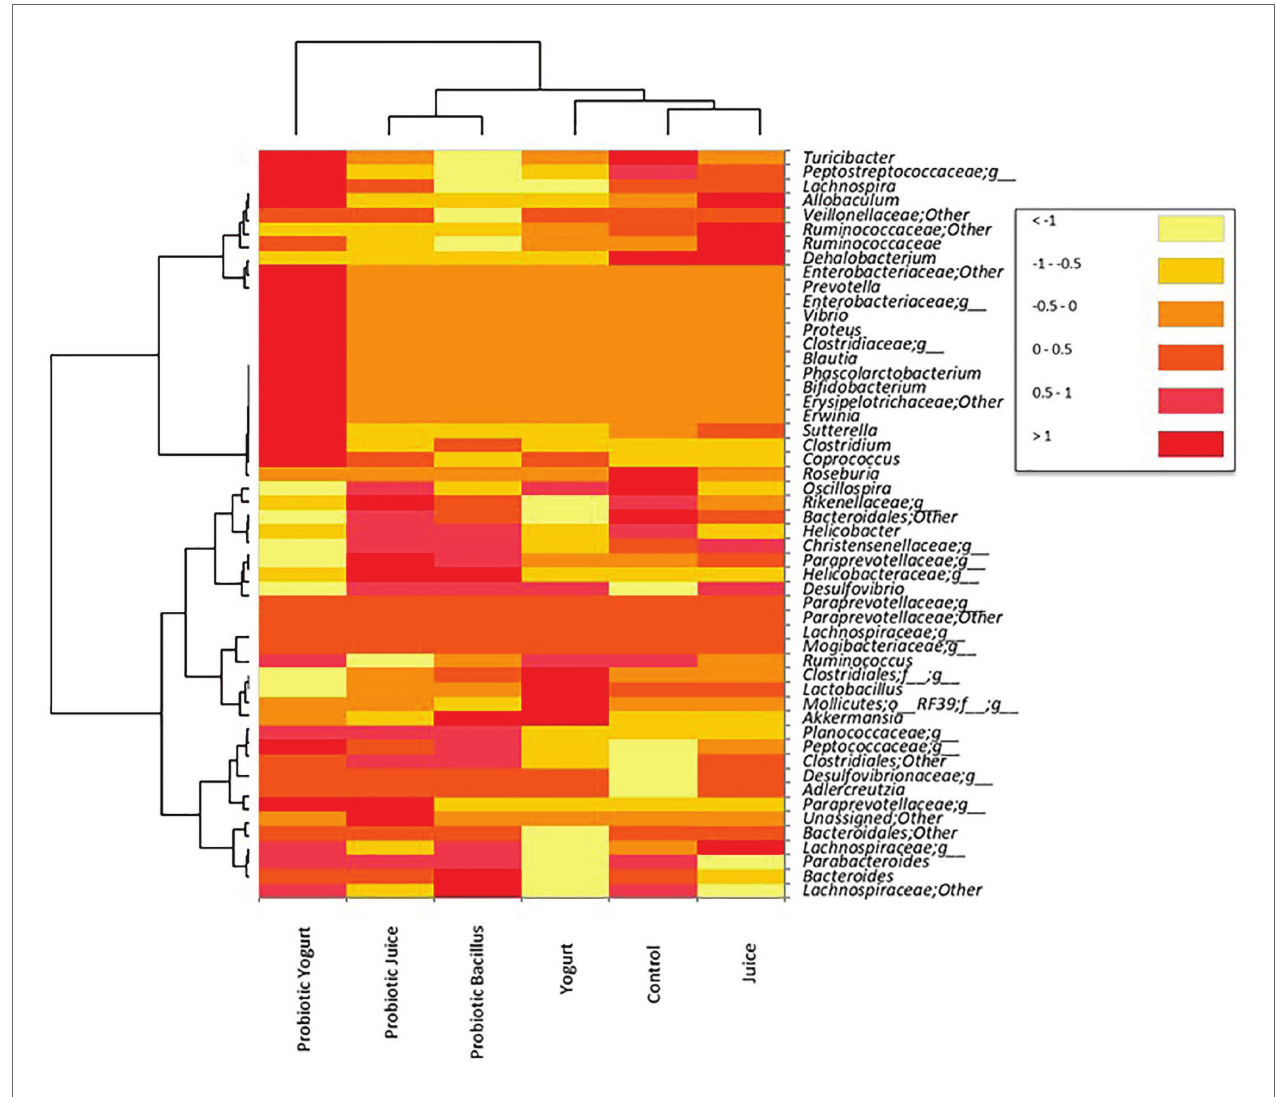
FIGURE 3 | Heatmap showing microbial taxa (mostly family level) with relative abundance obtained by 16S rRNA gene pyrosequencing analysis. Groups were as follows: Control: received distilled water; Juice: received orange juice; Yogurt: received yogurt; probiotic Bacillus : received B. coagulans GBI-30 6086 suspended in distilled water; Probiotic Juice: received orange juice with B. coagulans GBI-30 6086; and Probiotic Yogurt: received yogurt with B. coagulans GBI-30 6086. Only OTUs with abundance values above 0.1% in at least nine readings are